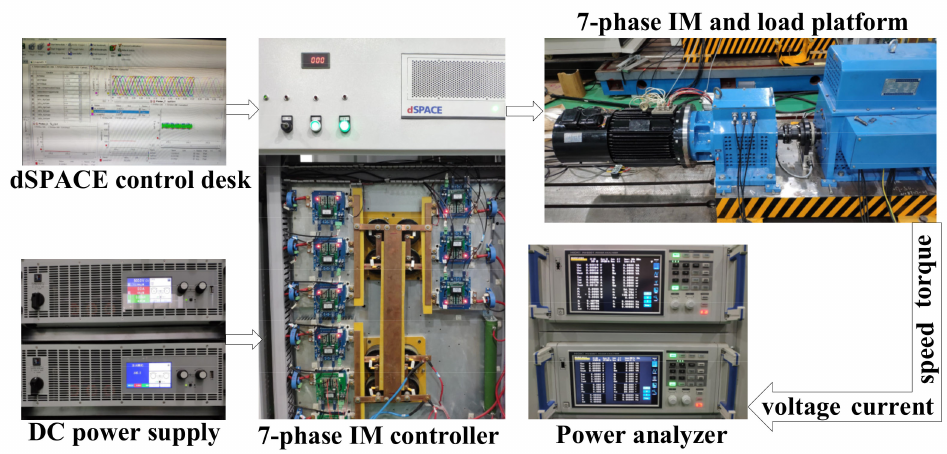
Figure 10. Seven-phase IM test